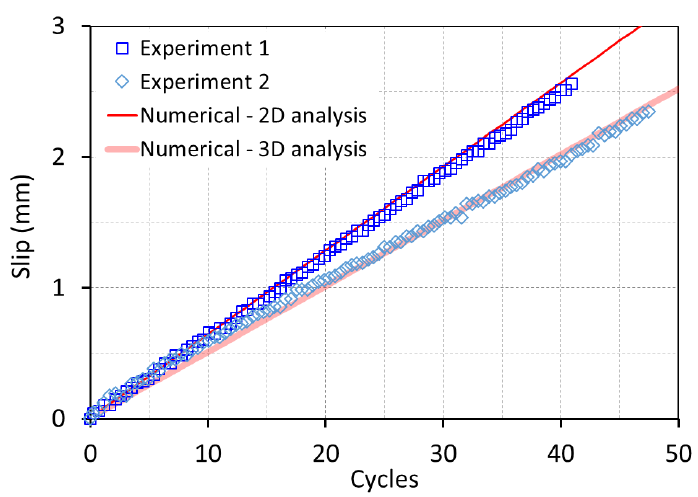
Figure 17. Effect of the two-dimensional (2D) and 3D analyses on the residual slip vs. the number of temperature cycles.